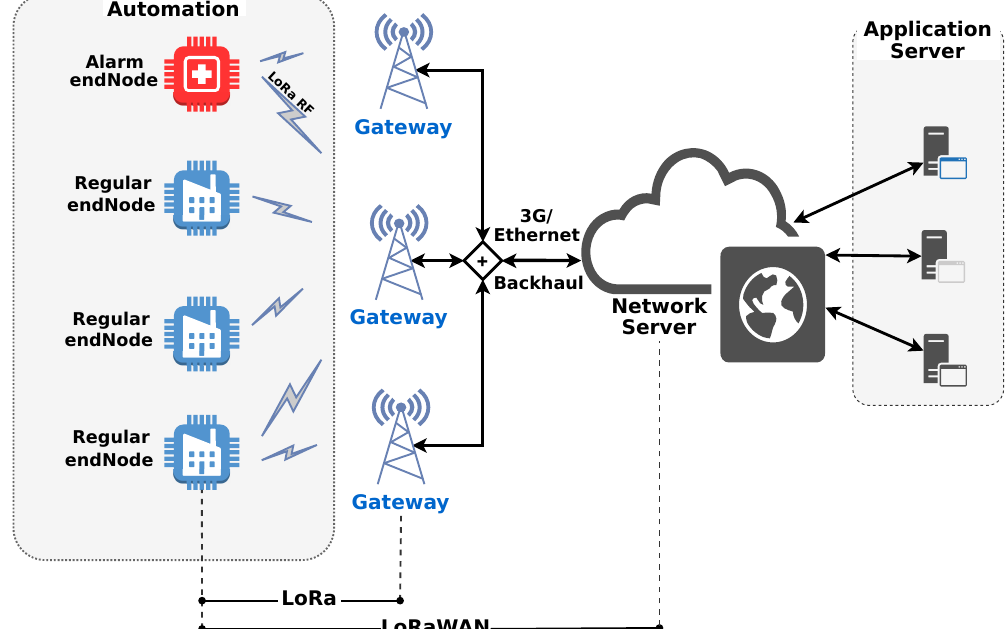
Figure 1. LoRaWAN architecture exemplified for industrial applications. The main elements are: end-nodes illustrated by sensors, gateways (depicted as base stations), network server